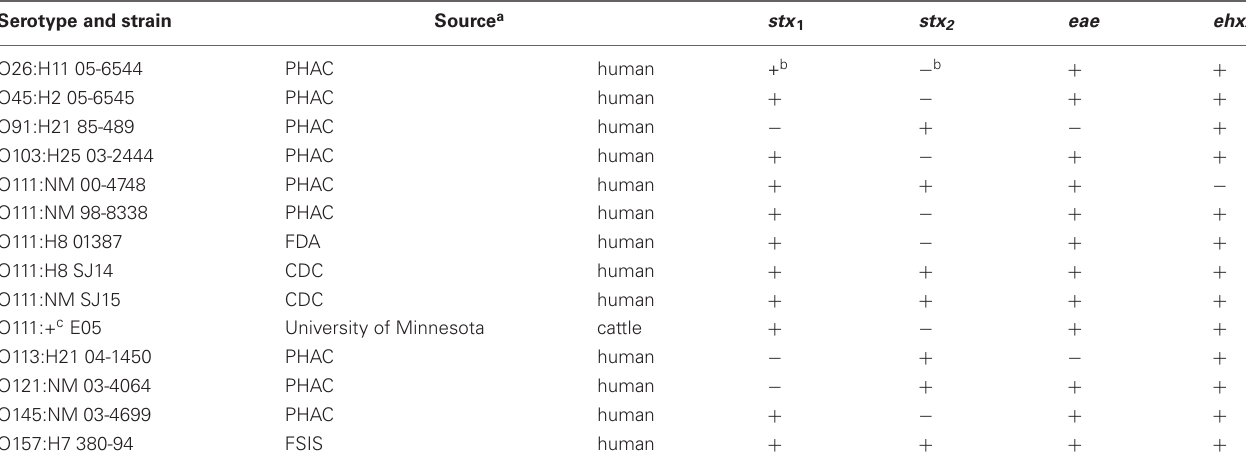
Table 1 | Serotypes, source, and virulence gene profiles of STEC strains used in this study. Serotype and